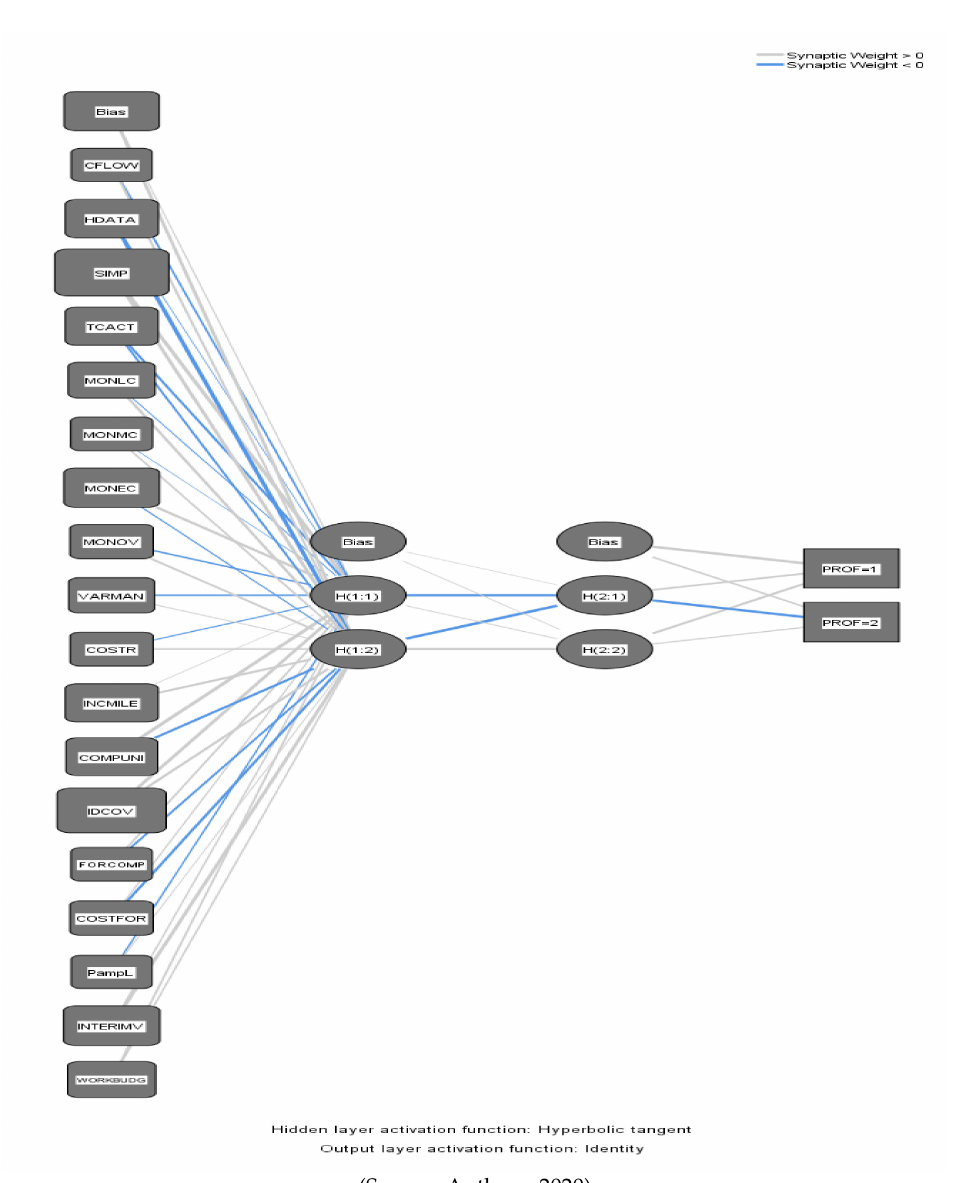
Figure 4. Validated multilayer